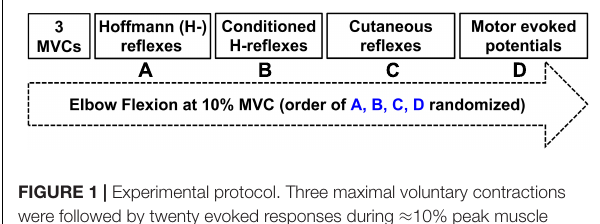
FIGURE 1 | Experimental protocol. Three maximal voluntary contractions were followed by twenty evoked responses during ≈ 10% peak muscle activation of the flexor carpi radialis (FCR) in a randomized order of (A) Hoffmann (H-) reflexes; (B) Conditioned H-reflexes; (C) Cutaneous reflexes; (D) Motor evoked potentials.